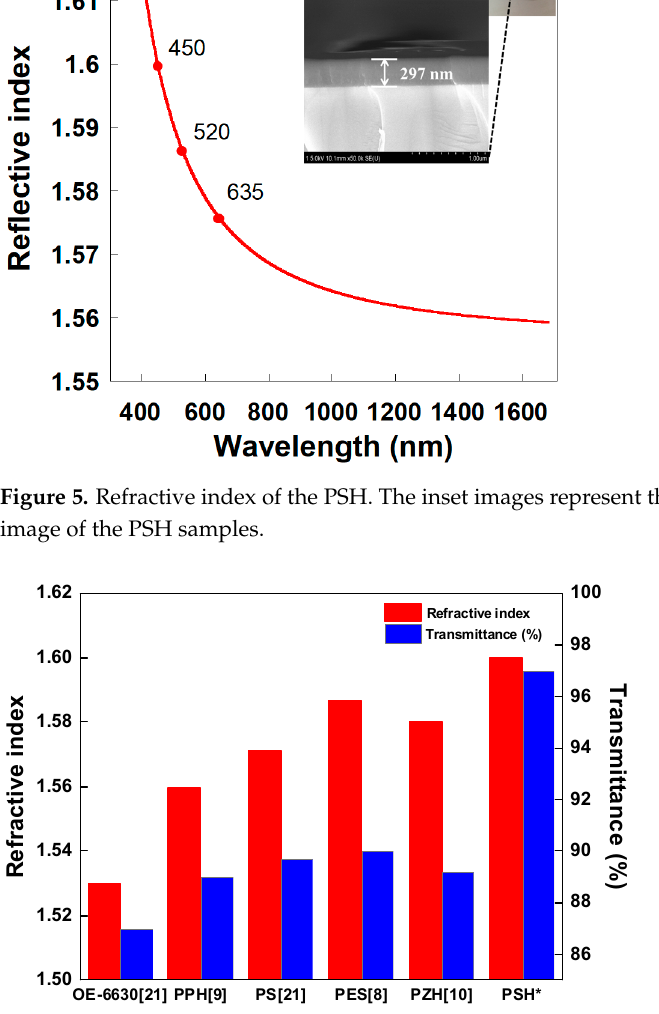
Figure 7. UV–Vis spectra of the silphenyl hybrimer (2 mm) before and after thermal aging at 180 °C for 72 h in air and the OE-6630 (Dow Corning, dotted orange line) ( A ). The photographs (middle) represent the pictures before and after the thermal aging test every 24 h. The change of transmittance of the PSH at 450 nm after thermal aging for 24, 48, and 72 h at 180 °C ( B ).